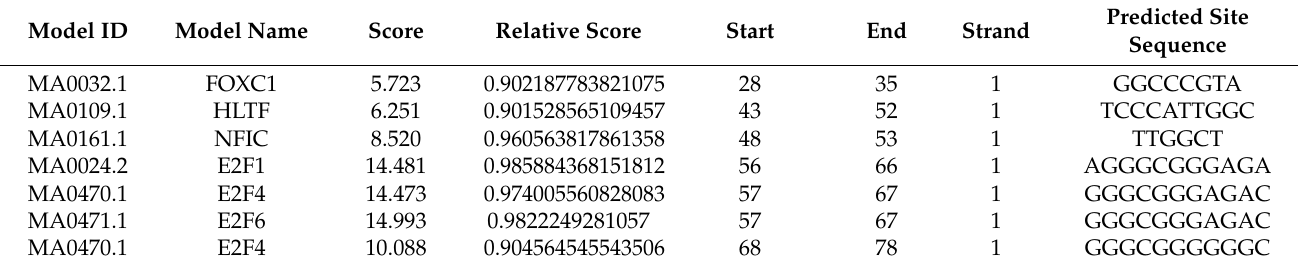
Table 5. Transcription factor binding sites of